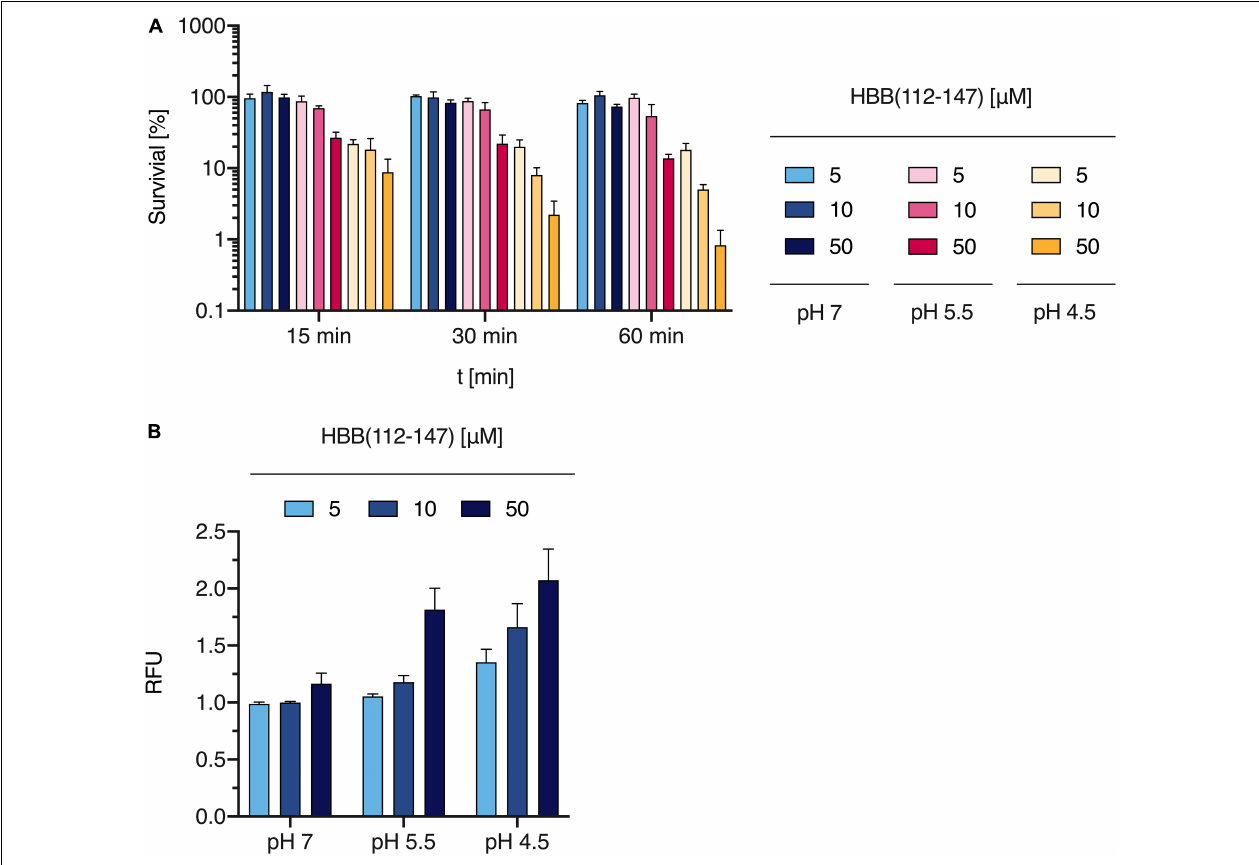
FIGURE 7 | Effect of HBB(112–147) on bacterial survival and membrane integrity. (A) The effect of HBB(112–147) on P. aeruginosa growth was quantified in a survival assay. 5, 10, and 50 µ M of the peptide were added to an overnight culture of P. aeruginosa at pH values of 7, 5.5, and 4.5 for 15, 30, and 60 min. Bacteria were quantified by CFU determination. Values are expressed as % of growth controls not exposed to HBB(112–147). Data shown are average values derived from three biological replicates + SD. (B) Plasma membrane damage of P. aeruginosa following HBB(112–147) treatment for 1 h at 37 ◦ C, was tested at indicated pH values by uptake of SYTOX green and subsequent quantification of fluorescence in a Tecan infinite M200 plate reader. Shown are mean values and SD of n = 3. Values shown are relative fluorescence units